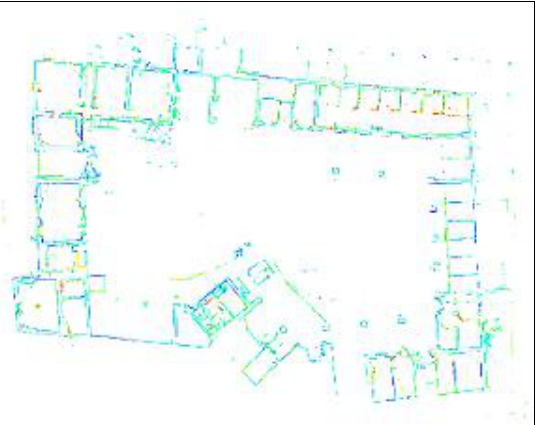
Figure 8. In particular, image 7 and 8 allow the study of main and secondary load-bearing structures composing the woody roofing, together with collaborating structural elements, as chains, highlighting the presence of eventual critical areas. Moreover, it is possible to get information related to the internal height of the building in comparison to the slope of the street.